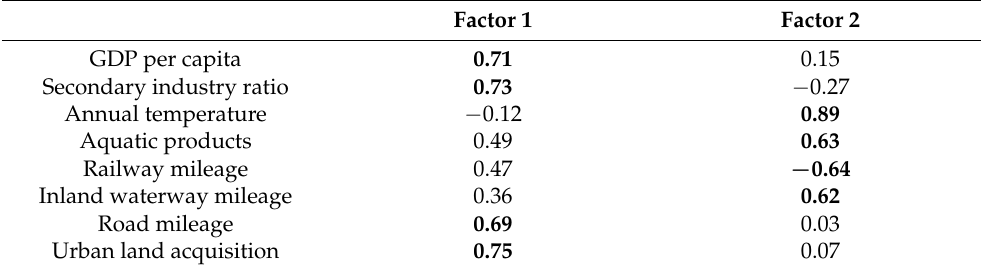
Table 1. Rotated loadings (Quartimax method) of the main climate and socioeconomic parameters on factors 1 and 2. Factor 1 Factor 2